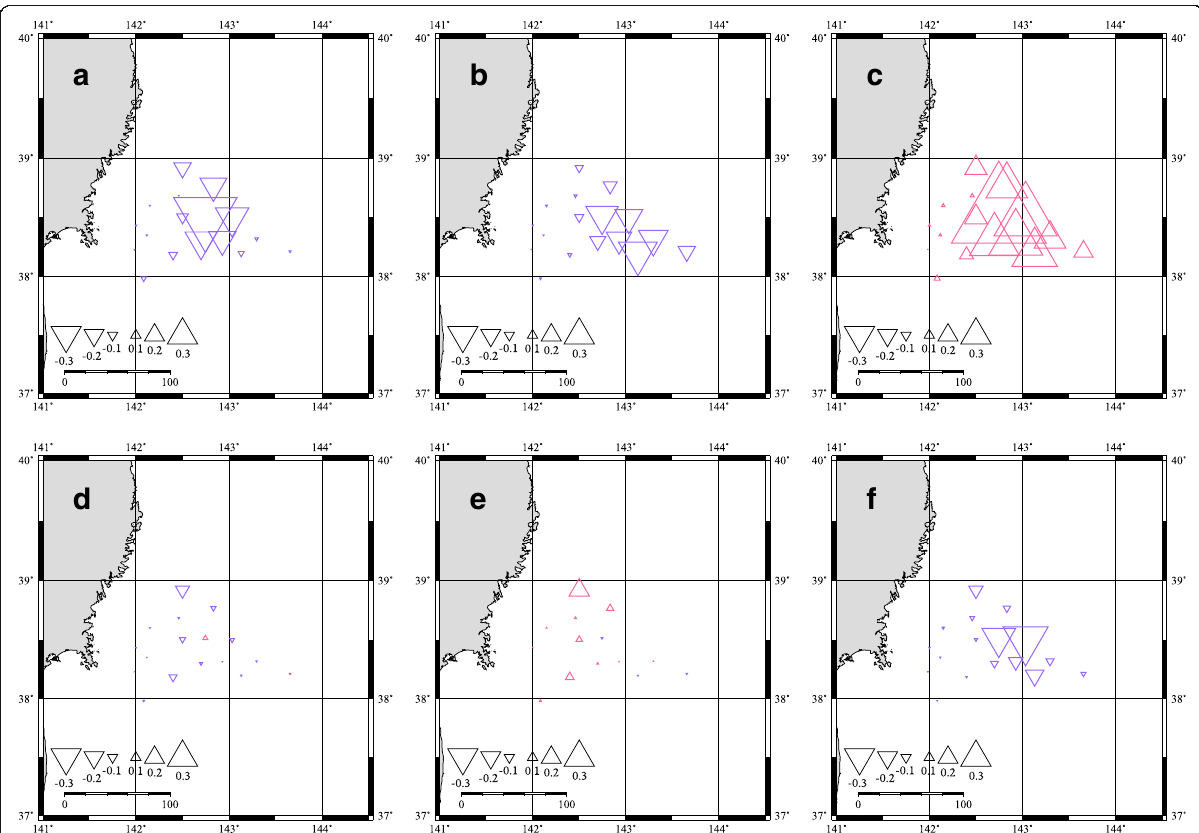
Fig. 6 Variations in cross-correlation coefficient averages for each period at a lag time of zero between the 15-day ACFs and the reference ACF, using a 15-s time window from 2.5 to 17.5 s at each OBS. These figures show variations in the cross-correlation coefficient averages a from period I to period II, b from period II to period III, c from period III to period IV, d from period IV to period V, e from period V to period VI, and f from period VI to period VII. Details of these periods are presented in Table 2. A red upward triangle represents an increase in the cross-correlation coefficient, and a blue downward triangle represents a decrease